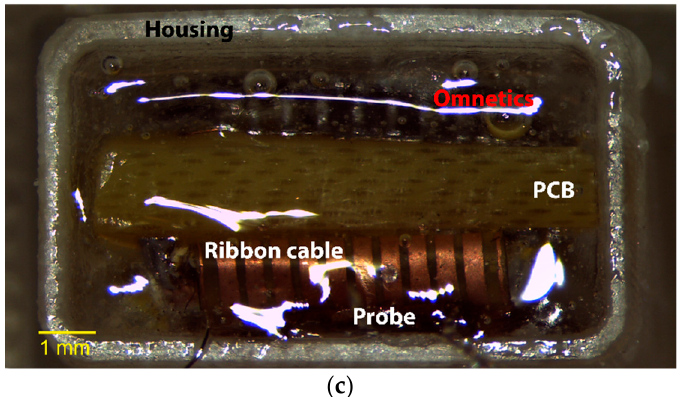
Figure 5. Packaged PVAc-CNC neural probes: ( a ) Front-view of probe in connector housing; ( b ) Assembly held with a custom clip for insertion; ( c ) Underside view of probe in connector housing, which shows the ribbon cable folded into the connector housing.